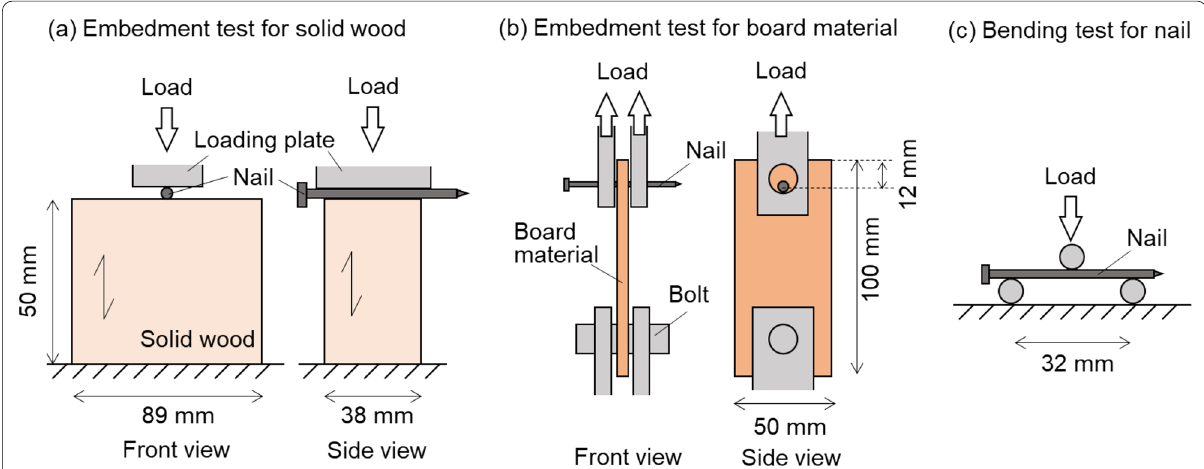
Fig. 4 Embedment tests and bending test for obtaining the characteristics used for calculating the yield load with European yield